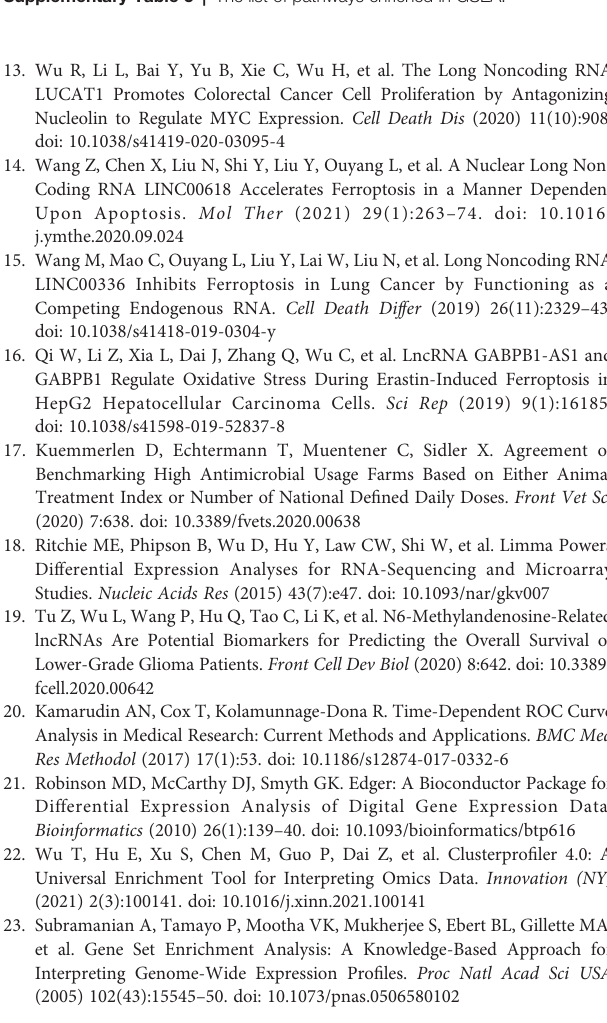
Supplementary Table 1 | The list of primer sequences used in our study. Supplementary Table 2 | The details of all of the ferroptosis-related genes. Supplementary Table 3 | The table of differentially expressed lncRNAs and ferroptosis-related lncRNAs. Supplementary Table 4 | The list of genes involoved in the coexpression network. Supplementary Table 5 | The list of pathways enriched in